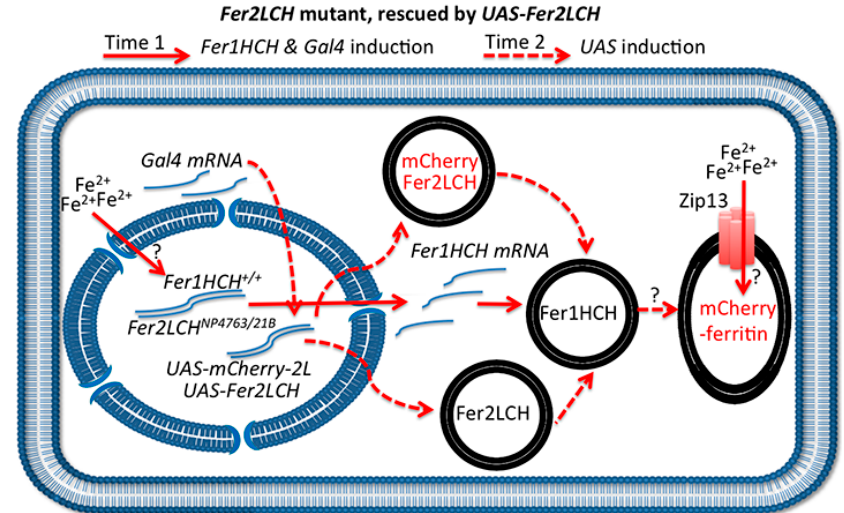
Figure 7. Schematic representation of the anterior midgut enterocyte from Fer2LCH 21BGal4 , UAS-Fer2LCH/Fer2LCH-Gal4 NP4673 , UAS-mCherry-Fer2LCH flies, fed on iron. The simultaneous (albeit delayed) expression of Fer2LCH and mCherry-Fer2LCH subunits in this genotype leads to the assembly and iron loading of mCherry-tagged ferritin. Solid red arrows indicate events taking place immediately after cytosolic iron sensing; dotted red arrows indicate subsequent Gal4/UAS dependent gene expression; question marks indicate that the detailed mechanisms of cellular iron sensing, ferritin assembly and iron loading remain unknown.